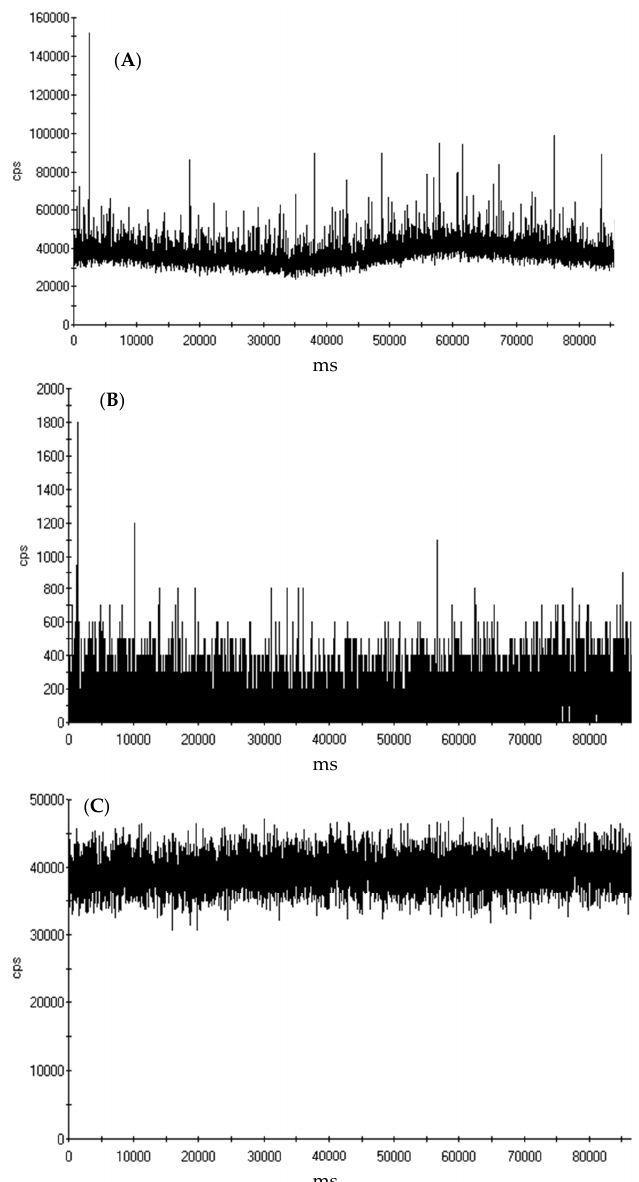
Figure 3. Yttrium single particle mode inductively coupled plasma mass spectrometry (spICP-MS) data of an ( A ) undissolved initial MWCNT sample, ( B ) undissolved MWCNT permeate, and ( C ) 2% HNO 3 dissolved MWCNT permeate passed through a 30 kDa ultrafilter, showing that Y did not pass through the ultrafilter unless acidified and dissolved by 2% HNO 3 .